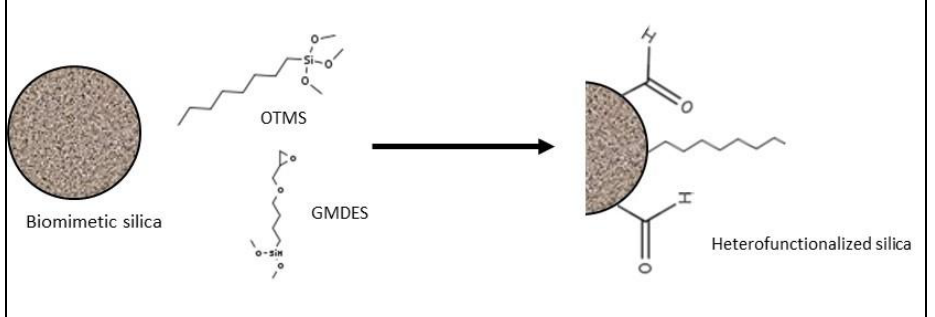
Figure 17. Scheme of heterofunctionalization of the biomimetic silica surface.